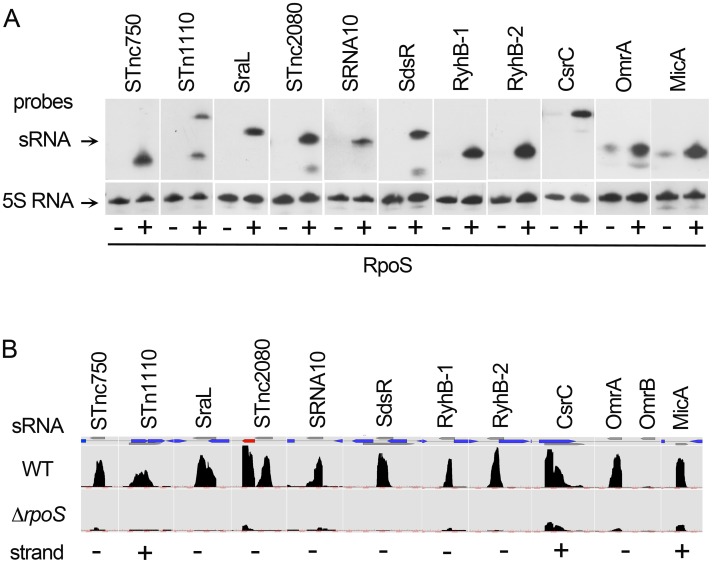
σS-dependent expression of small RNAs in Salmonella.(A) The indicated sRNAs were detected in Northern experiments in the wild-type strain ATCC14028 (+) and its ΔrpoS derivative VFC331 (−). The positions of bands were in agreement with the expected transcript lengths [28], [64], [65] (Table S3) except for STnc1110 (195 nt, detected with an additional band of 120 nt) that might be processed in late stationary phase. Blots were stripped and re-probed with 5S RNA probe to confirm loading of equal quantities of wild type and ΔrpoS RNA. (B) Mapped reads, in the wild-type and ΔrpoS strains, VF7969 and VF9356 respectively, of the σS-dependent RNAs assessed in Northern experiments. The mapped reads were formatted into graph files for visualization at a strand-specific manner using COV2HTML. The annotated sRNA genes are indicated as grey arrows and open-reading frames annotated in ATCC14028 are shown as blue arrows. Open-reading frames overlapping the sRNAs are small putative CDS of unknown function annotated in ATCC14028. STnc2080 is located upstream of STM14_3200, indicated in red, a gene directing the synthesis of a tRNA-Arg and activated by σS (Dataset S2). SdsR is complementary to a portion of the sRNA transcribed from the opposite strand, SraC. The scale for read counts on the y axis was 1–250 for STnc1110 and sRNA10, 1–1000 for OmrA and MicA, 1–2500 for STnc750 and RyhB-1, 1–5000 for STnc2080 and RyhB-2, 1–10000 for SraL, SdsR and CsrC.